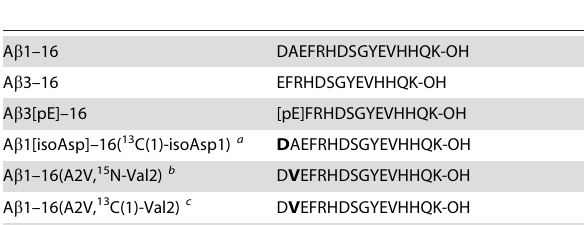
Table 1. A b x–16 peptide sequences employed in this study, with labelled residues given in